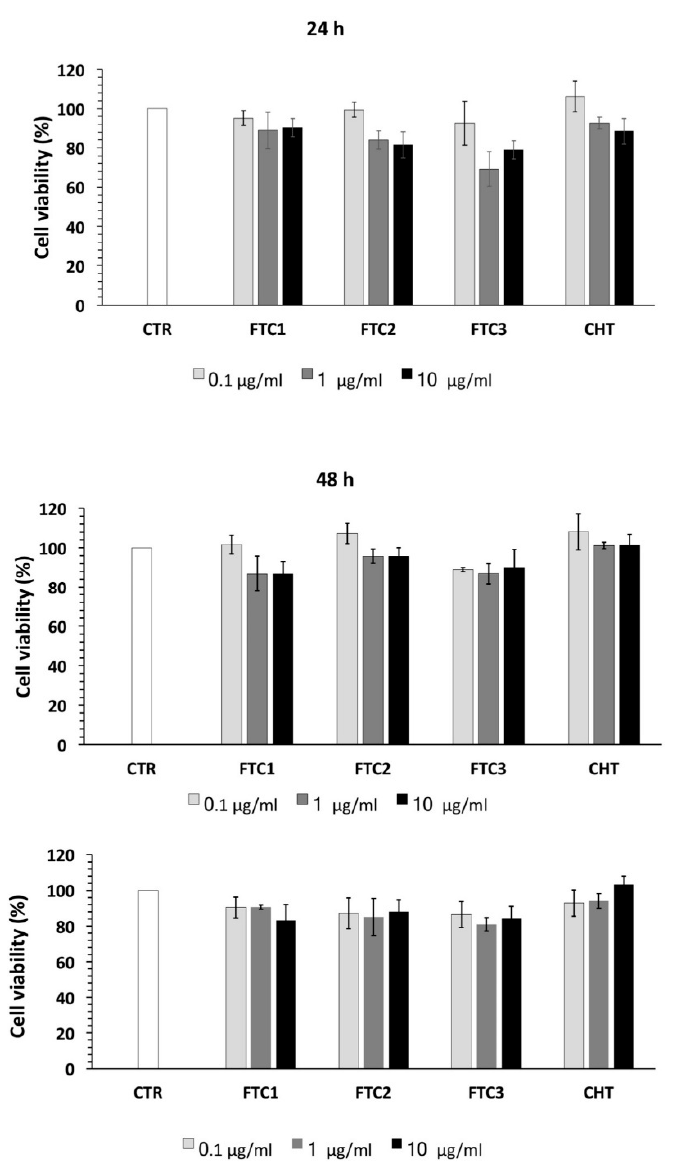
Figure 5. HeLa cell viability tested by 3-(4,5-dimethylthiazol-2-yl)-2,5-diphenyltetrazolium bromide (MTT) assay in triplicate. Cells were incubated with blank (control, CTR), and FTC- and CHT-based NPs at different concentrations for 24, 48, and 72 h. The results are expressed as the percentage of the control assumed as 100%. Each value represents the mean ± SD of three independent experiments.